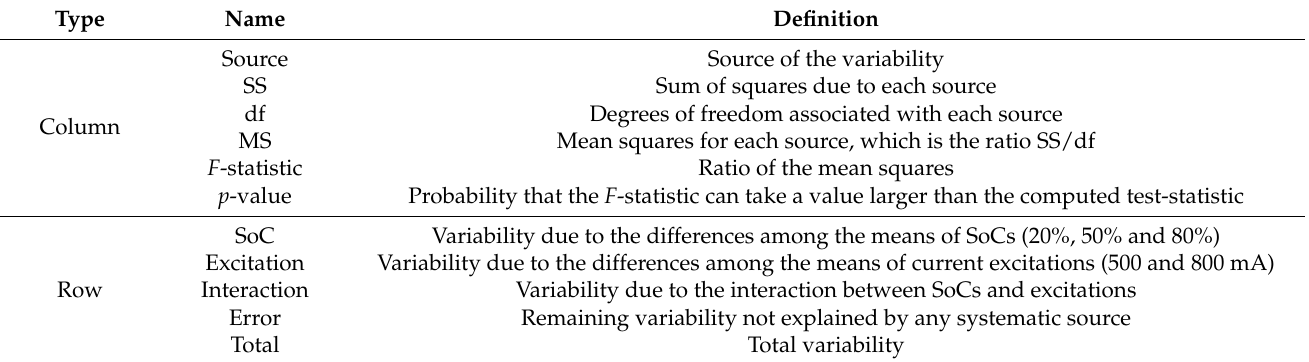
Table 5. The definitions of the output arguments of two-way